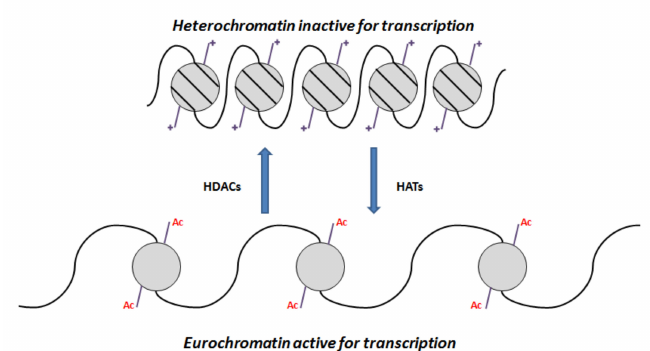
Figure 1. Chromatin regulation of transcriptional activity. Histone deacetylation induces the closure of the chromatin and acetylation induces an open chromatin structure.